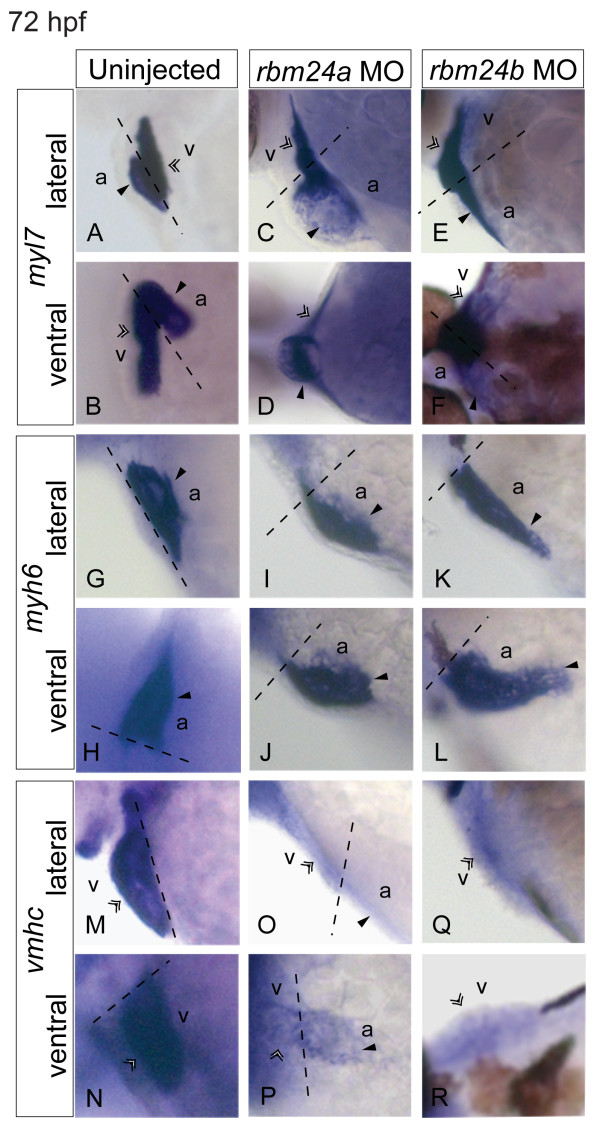
Depletion of rbm24a and rbm24b compromise cardiac myocardial development. The expression patterns of cardiac markers were analyzed in rbm24 morphants and uninjected controls at 72 hpf. Ventral and lateral images of the heart are shown with a dotted line marking the boundary between heart chambers. By myl7 expression of the entire heart, uninjected controls possess looped hearts with defined ventricle and atrium chambers (A, B) in contrast to unlooped hearts for both rbm24 morphants. rbm24a morphants displayed linear presumptive ventricle and an incompletely formed presumptive atrium (C, D). rbm24b morphants displayed a linear presumptive atria and ventricle (E, F). myh6 marking the atrium displayed a looped atrium in controls (G, H) with linear atrium in rbm24a (I, J), and rbm24b morphants (K, L). vmhc expression demarks looped ventricles in controls (M, N). rbm24a morphants displayed little expression bound to an unlooped heart tube where expression extends to the presumptive atrium (O, P). Almost no vmhc expression is detectable in rbm24b morphants (Q, R). v, ventricle region; double arrow, ventricular expression a, atrium region; solid black arrow, atrial expression.